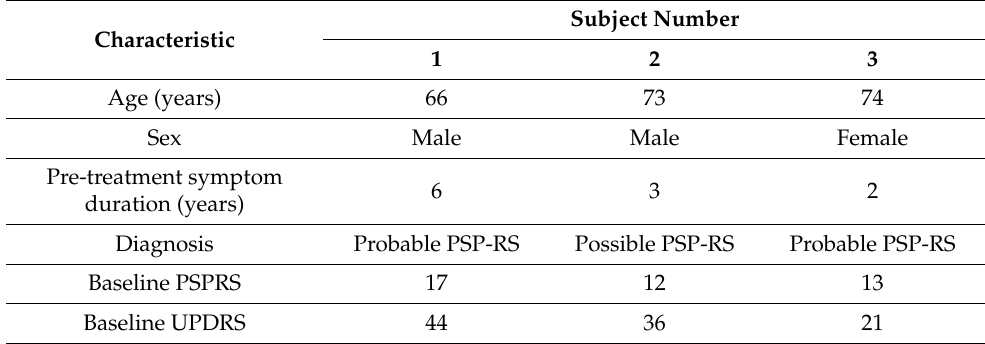
Table 1. Demographic and baseline PSP characteristics for the three subjects at the onset of